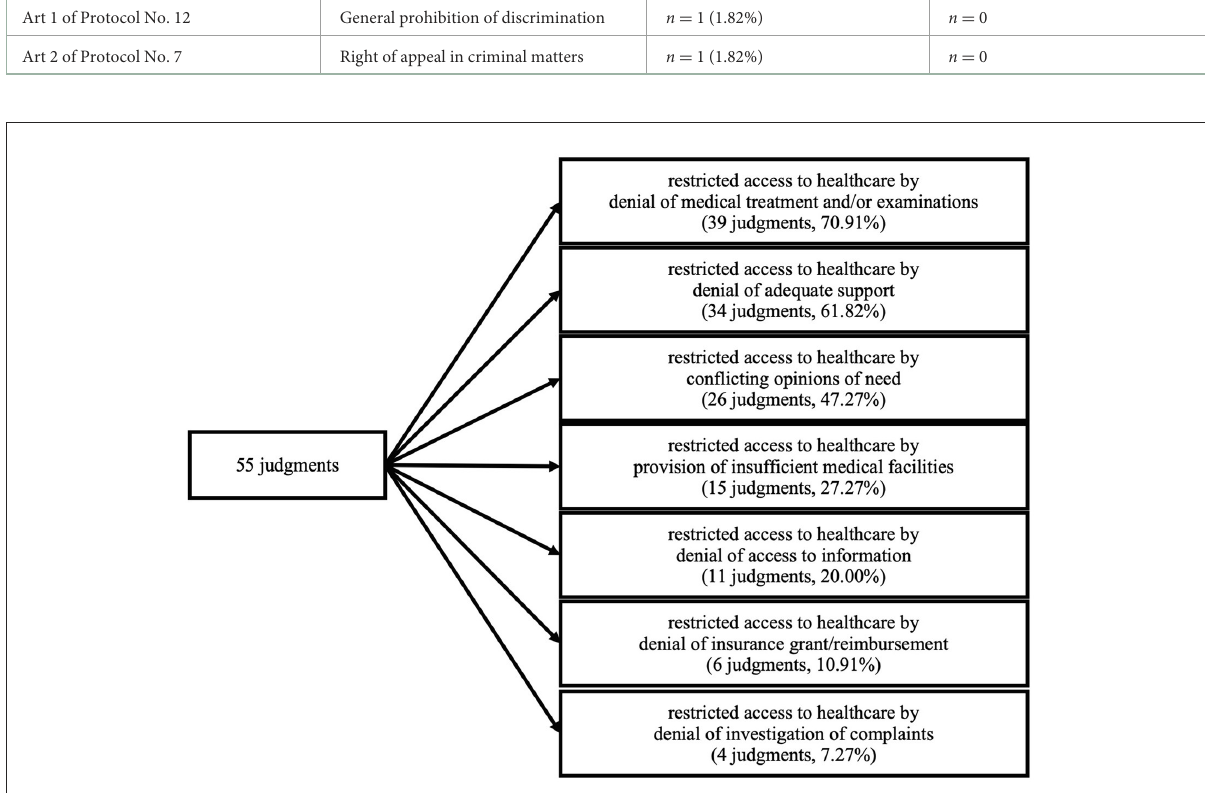
FIGURE3 General count and percentages of judgments we found regarding each